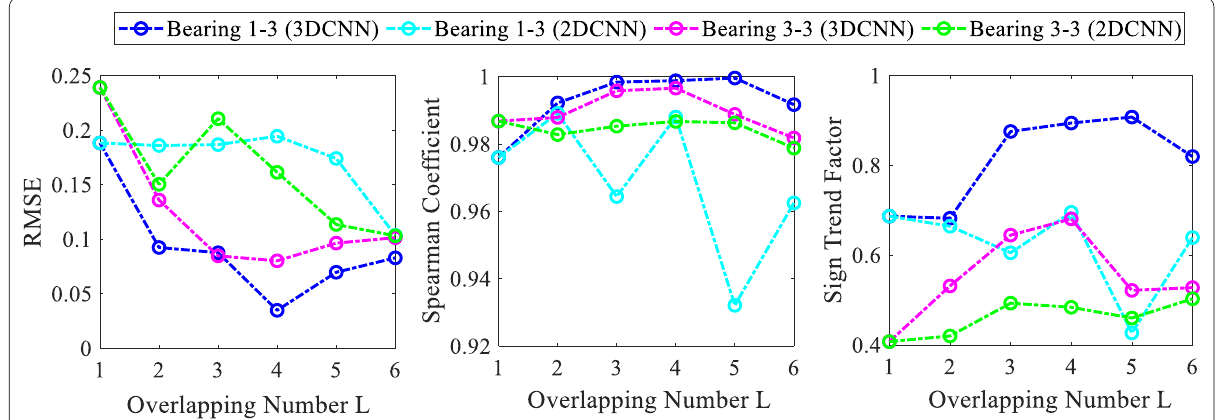
Figure 8 RMSE, Spearman rank correlation coefficient and sign trend factor of bearings 1-3 and 3-3 with different overlapping numbers and convolutional